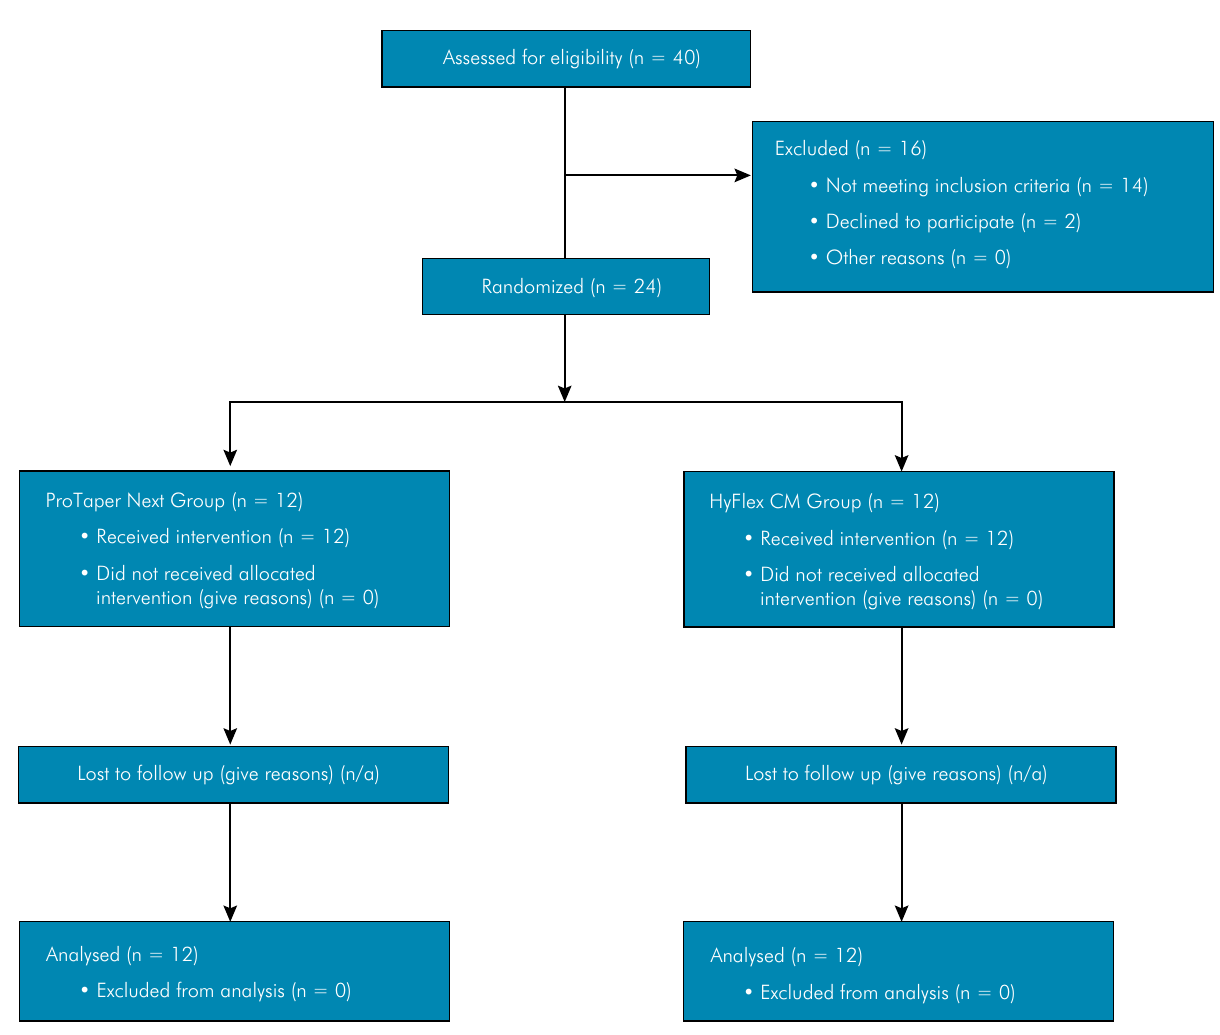
Figure 1. Consolidated standards of reporting trials flow